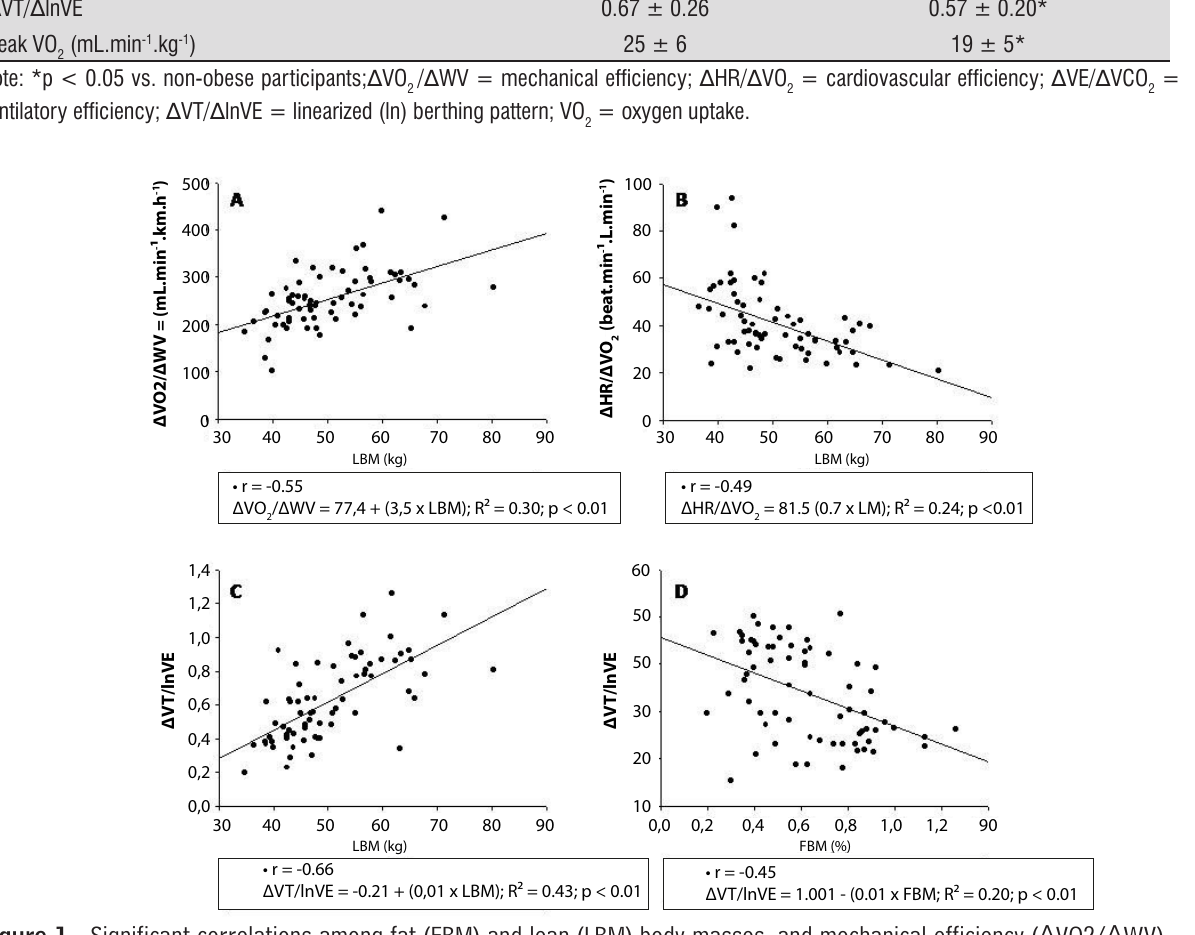
Body mass index (kg.m -2 )